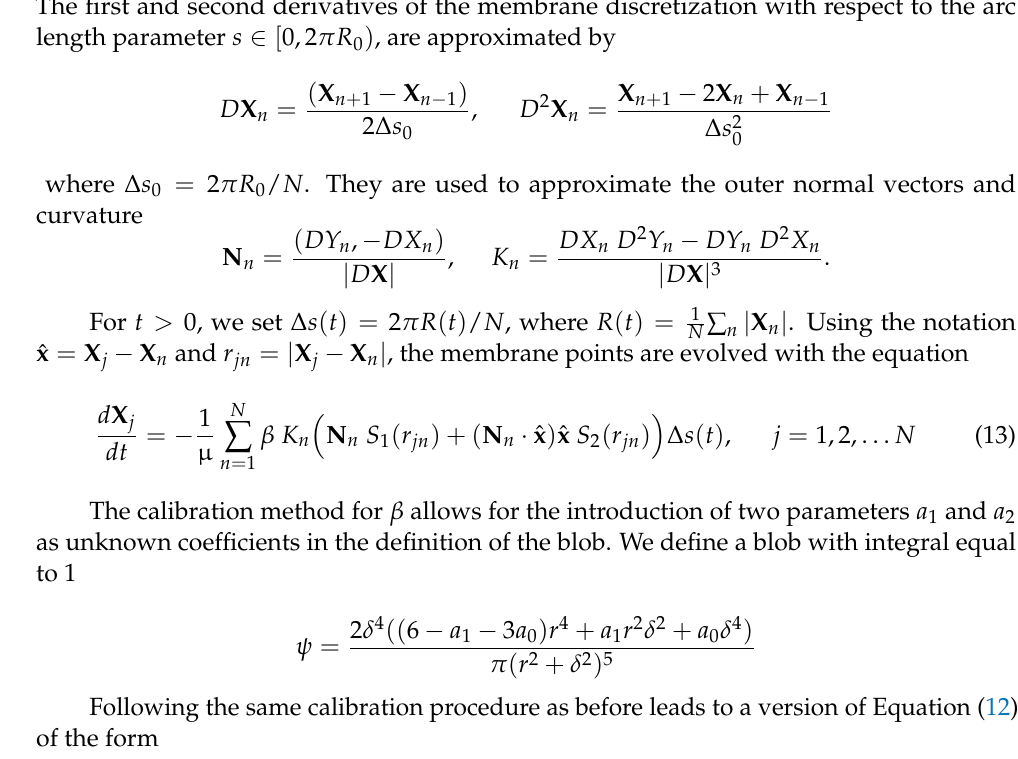
Figure 2. Numerical solution of the ODEs for R ( t ) for the blobs φ δ ( r ) = 2 δ 4 4 ( r 4 − 10 r 2 δ 2 + 5 δ 4 ) ψ ( r ) = 2 δ (blue). The dashed curve is the exact solution of the problem. The left π ( r 2 + δ 2 ) 5 panel shows results for a constant regularization δ = 0.1. The right panel shows results when the regularization size is varied dynamically according to δ = 0.1 R ( t )